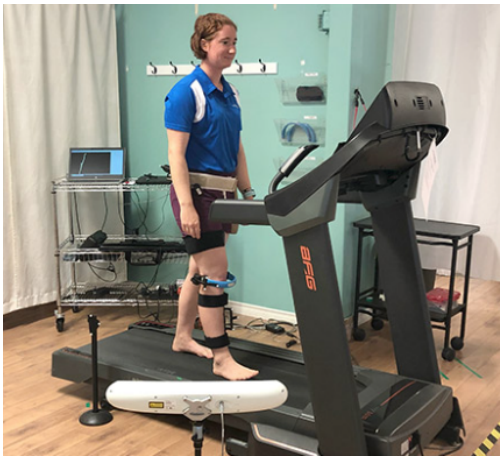
Figure 1. Knee kinematic acquisition system. Measures are captured while walking on a conventional